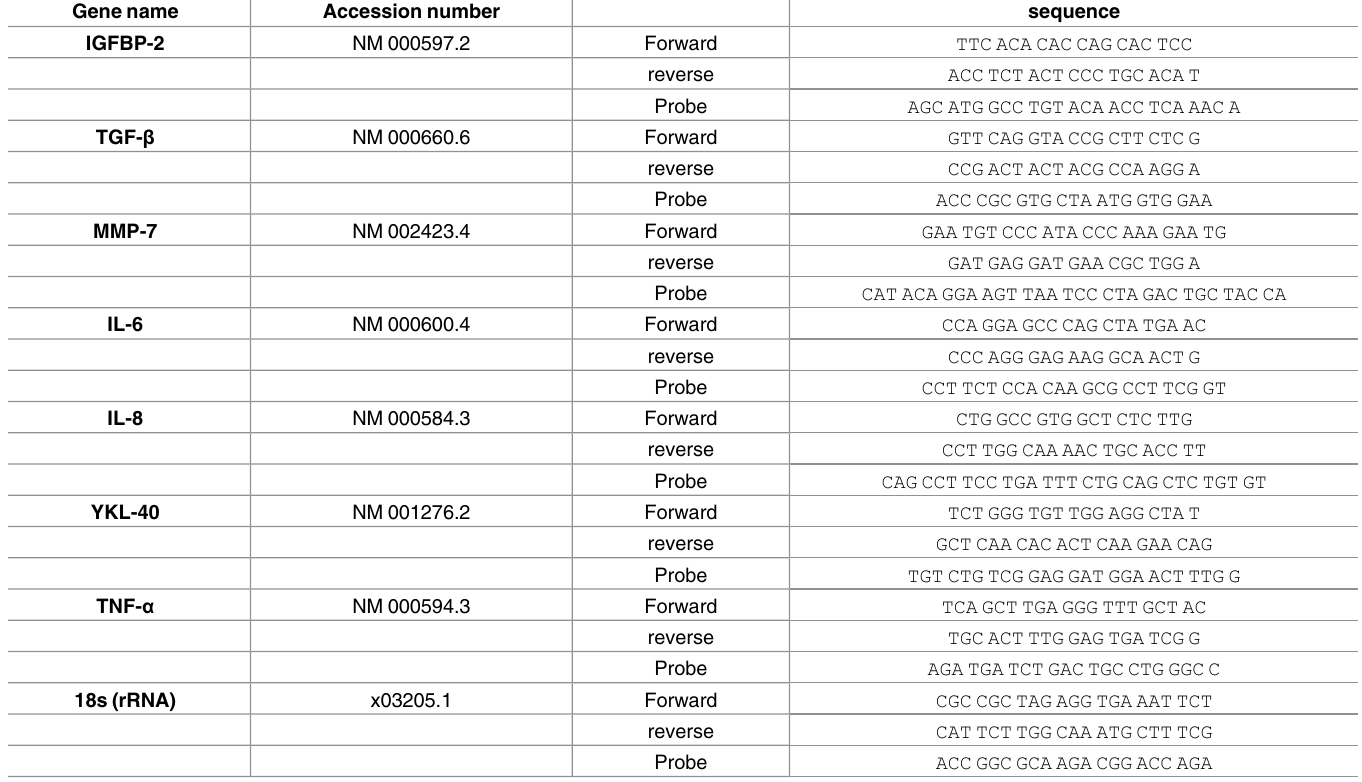
Table 1. Sequence of primers and